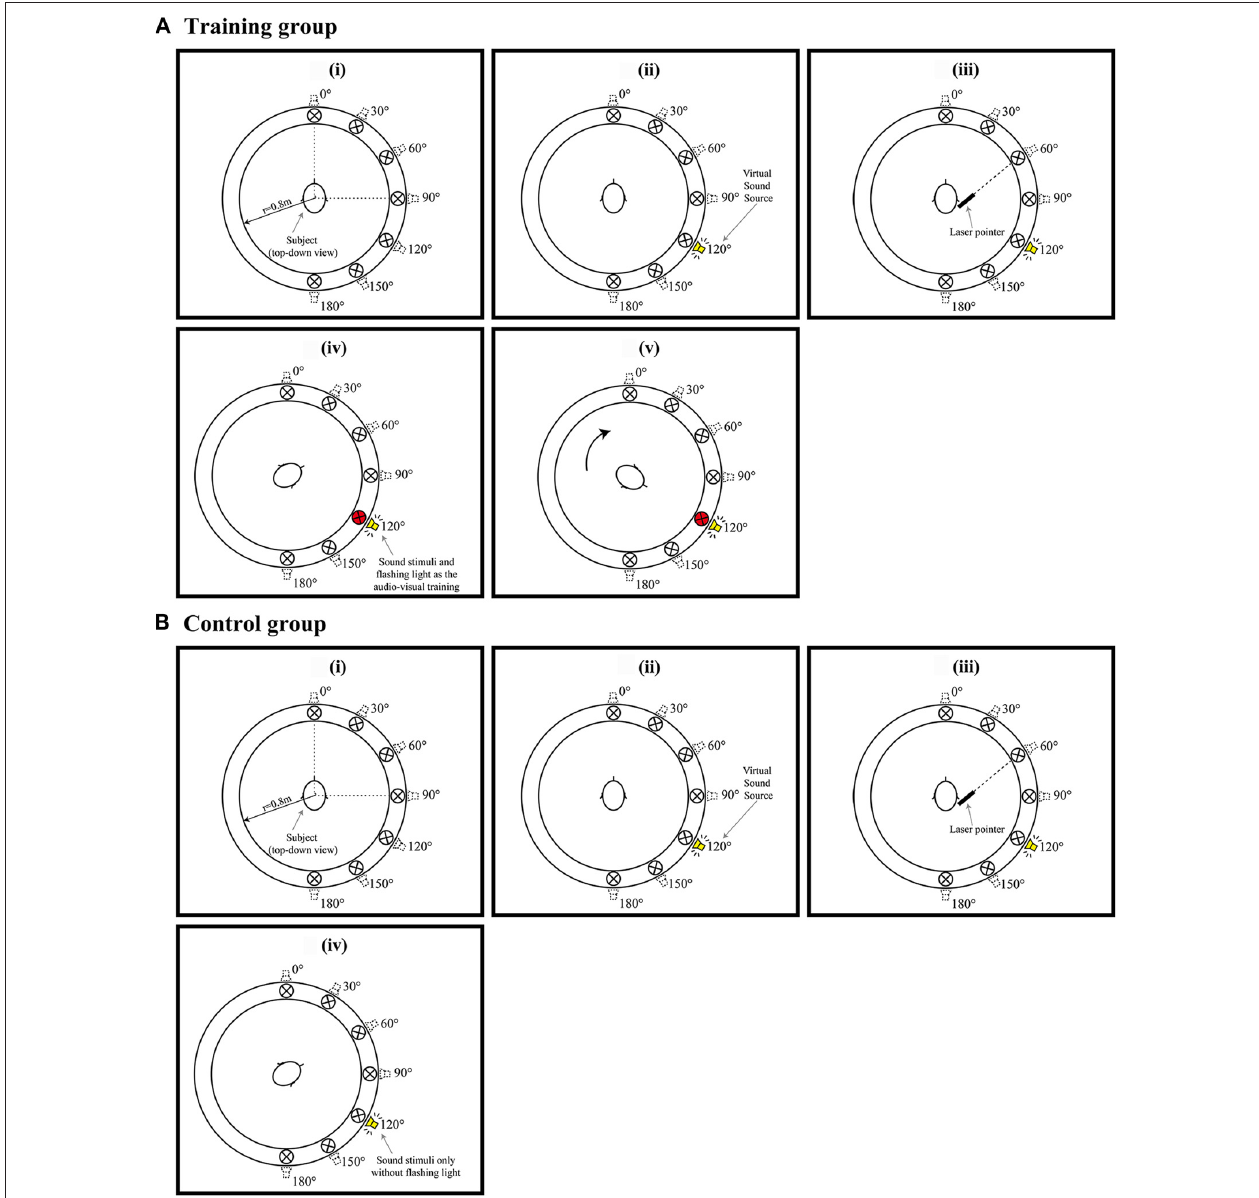
FIGURE 2 | (Ai–v) Example of a trail when the audiovisual training conducted. (Bi–iv) Example of a trail when Only auditory training conducted. Red circles in (Aiv,v) represent a visual LED indicator of the correct sound position paired with a spatialized auditory stimulus. (Av) shows the participants were subsequently requested to response and look the visual LED indicator at that direction and listen the auditory stimuli with LED presented simultaneously and repeatedly 10 times.